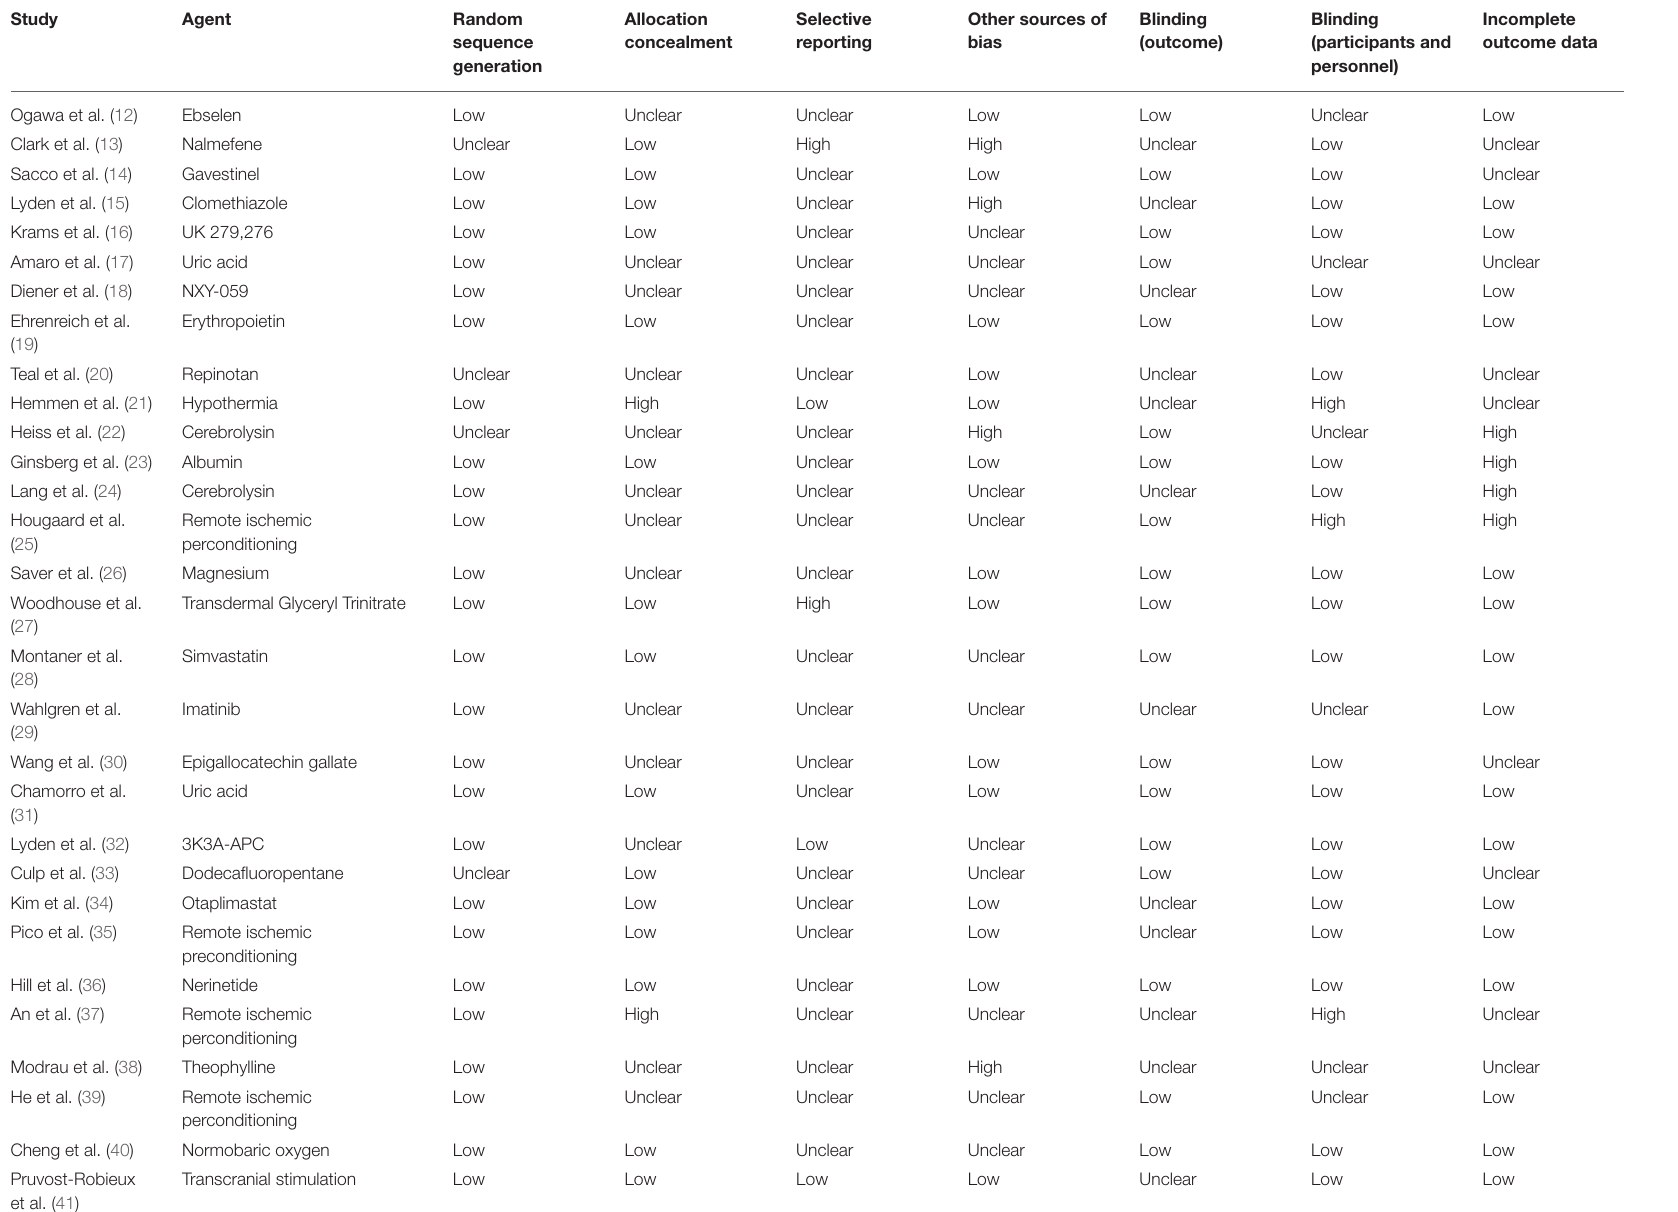
TABLE 3 | Cochrane risk of bias